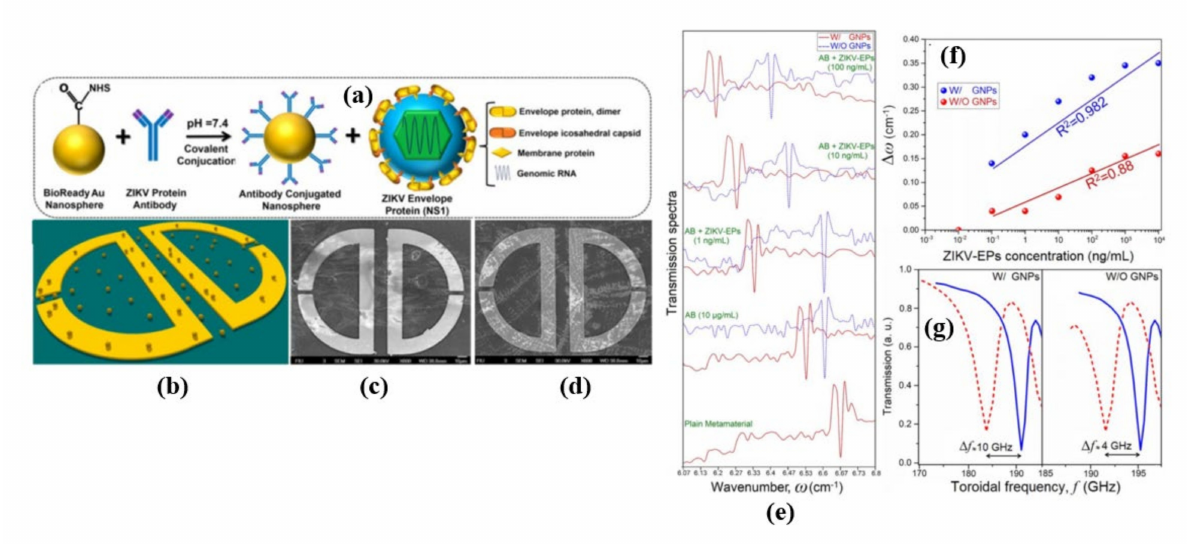
Figure 8. ( a ) Schematic flowchart of functionalized gold nanoparticle conjugation with ZIKV-AB and ZIKV-EPs NS1 with an explanation of the different parts. ( b ) Schematic representation of gold-nanoparticle-integrated toroidal unit cells. SEM images of a plasmonic metamolecule in the presence of ( c ) GNPs with AB and ( d ) ZIKV-Eps. ( e ) Transmission amplitude spectra for W/and W/O GNPs regimes in the presence of ZIKV-AB and ZIKV-EPs with different concentrations. ( f ) The toroidal resonance shift as a function of ZIKV-EPs concentration W/and W/O GNPs, and ( g ) the magnified transmission spectra as a function of frequency. Reprinted with permission from